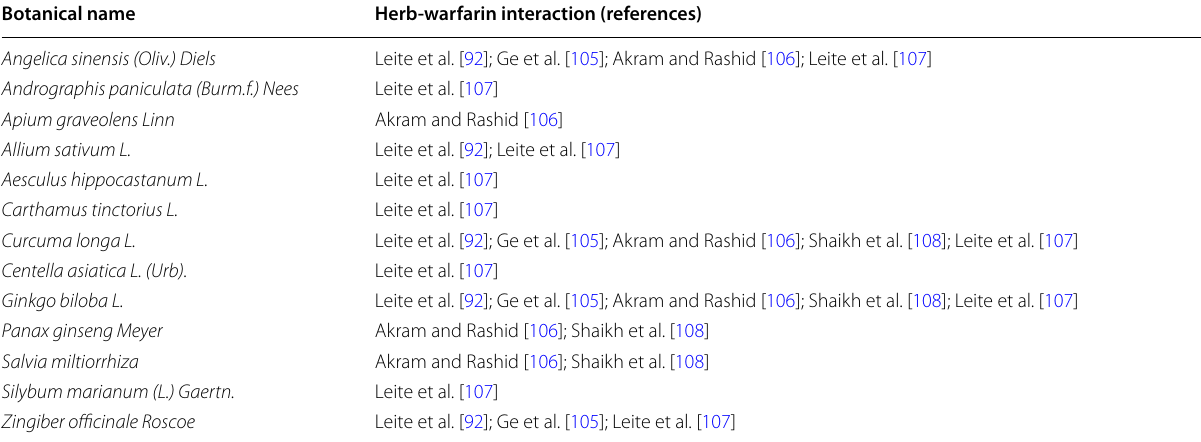
Table 6 List of herb-warfarin interaction causing increased risk of bleeding Botanical